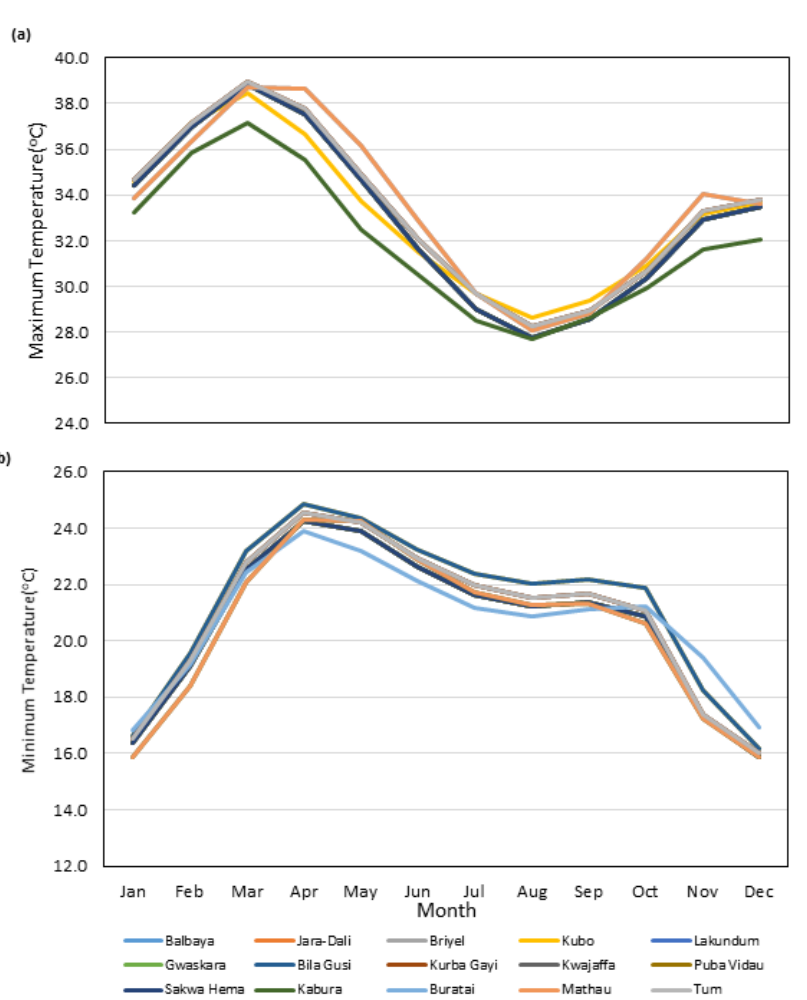
Figure 4. Average monthly variations of ( a ) maximum temperatures and ( b ) minimum temperatures between 1985 and 2010 across the simulation sites in Borno State. The coefficients of variation (CV) ranged from 3.0 to 3.7% for maximum temperature and 2.0 to 2.3% for minimum temperature. In Adamawa State (Table 7), the seasonal rainfall (May-Oct.) for all of the sites over the 31-year period (1985–2010) ranged from 851 to 1104 mm. It was observed that the rainfall in Dulmava, Hushere Zum, and Guyaku and Tawa was slightly higher (>1000 mm) than in the other locations. The average monthly maximum temperature across the sites over the climatic period ranged from 27.5 to 39.1 ◦ C (Figure 3a), while the average monthly minimum temperature ranged from 15.8 to 24.9 ◦ C (Figure 3b). In Borno State (Table 8), the seasonal rainfall over the 31-year period (1985–2010) across the sites ranged from 883–998 mm with high inter-seasonal variability, varying from 18 to 22%. The average monthly maximum temperature across the sites over the climatic period ranged from